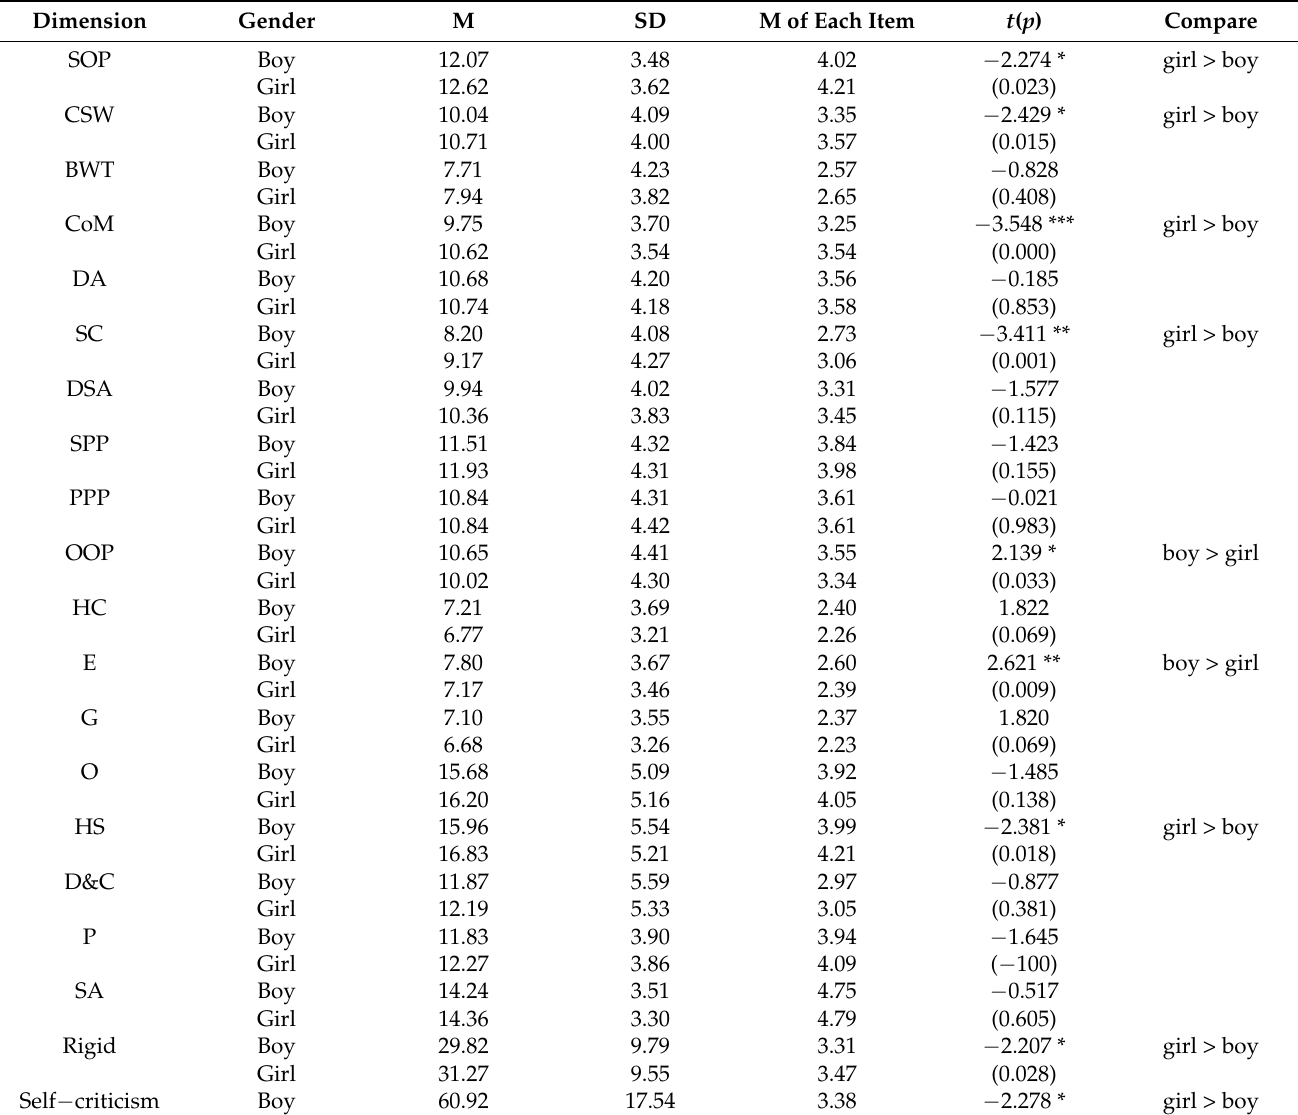
Table 3. The difference in perfectionism by